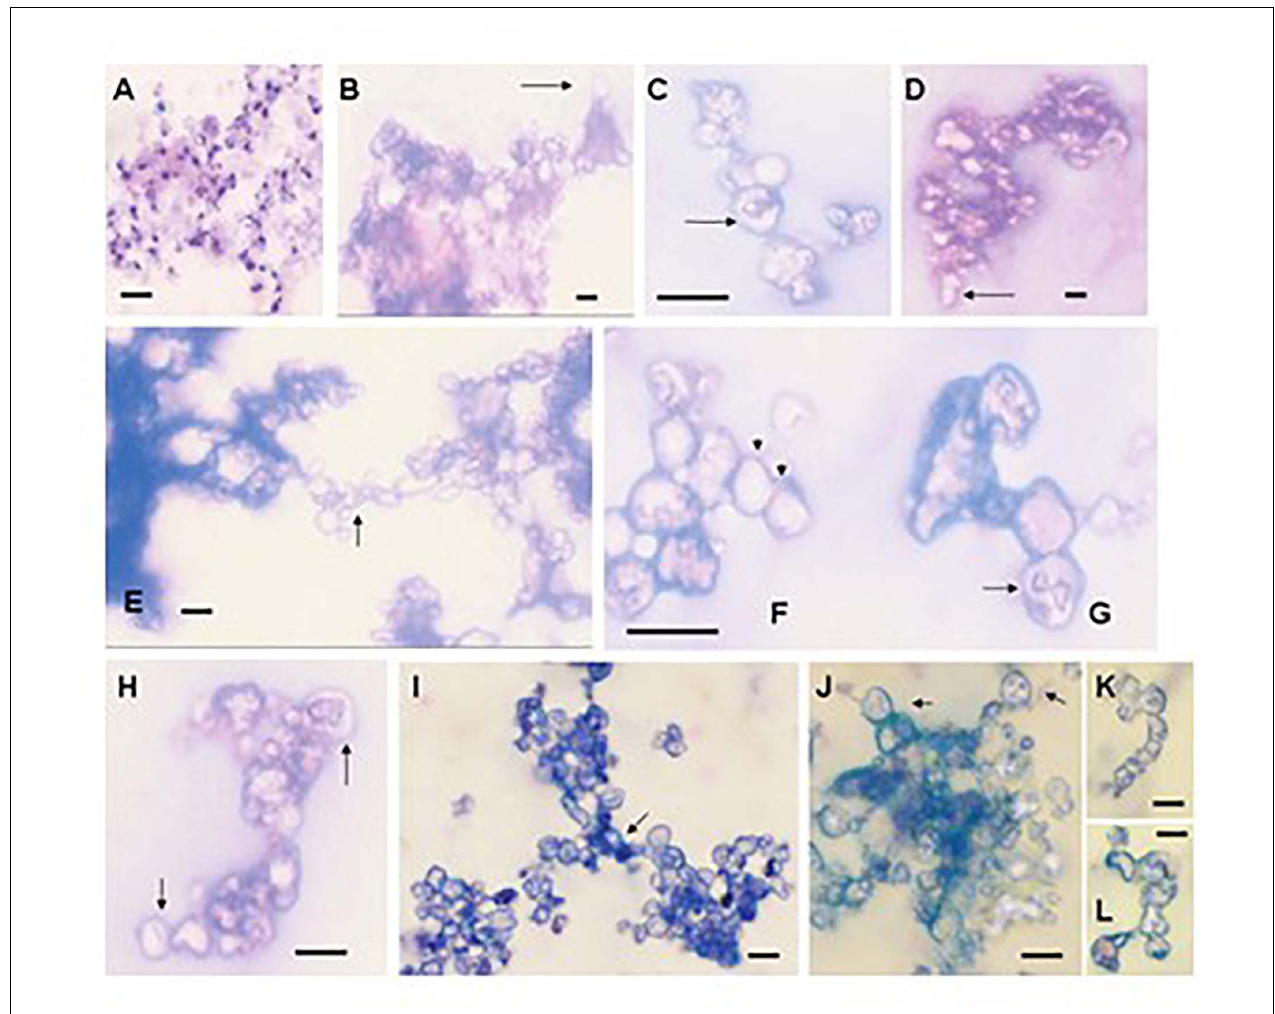
FIGURE 2 | The morphology of Pneumocystis changes dramatically during biofilm formation. (A) P. carinii from the supernatant of a 3-day-old standard short-term culture stained with Hema3, illustrating the differences in morphology from the biofilm structures. (B–H) Images were taken from 16-day-old biofilms inoculated with P. murina (obtained as a fresh isolate). The images were obtained from films on inserts that were scraped with a pipette tip, aspirated, air dried, and stained with Hema3, a rapid Wright-Giemsa stain. Images were viewed under oil immersion. Bars, 10 m. (B) P. murina cluster showing a cyst-like structure with a stalk (arrow). (C) An ascus in a chain with intracystic forms. (D) Refractile cluster beginning to form extensions (arrow). (E) Two large clusters forming a linkage or bridge structure (arrow). (F) A series of cyst-like structures forming a chain (arrows). (G) Cyst containing a structure which appears to be trophic forms undergoing binary fission or conjugation (arrow). (H) Ascus-like forms containing intracellular spore-like morphologies (arrows). (I–L) Images were taken from P. carinii biofilms at day 9 of the first passage. (I) Cluster mass seemingly comprised of three clusters that have joined in the center (arrow). (J) Ascus-like structures in a cluster with obvious intracellular contents resembling spores (arrows). (K,L) Chain-like forms. Bars, 10 µ m (Cushion et al.,